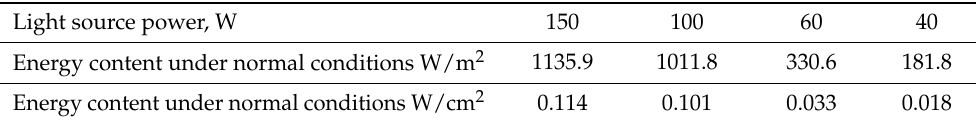
Table 1. Correlation of light source power W under normal conditions in W/m 2